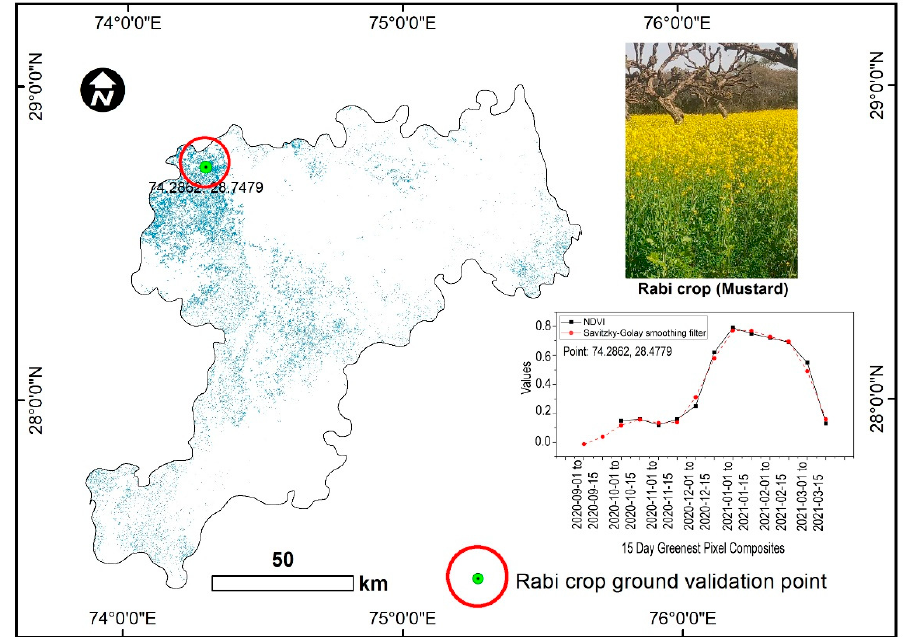
Figure 14. Rabi crop ground validation point example with photograph (Datum: WGS84).